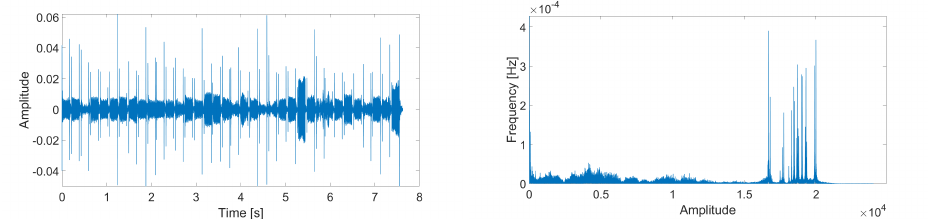
Figure 7. The audio signal in the time domain ( left ) and frequency domain ( right ) for the recorded